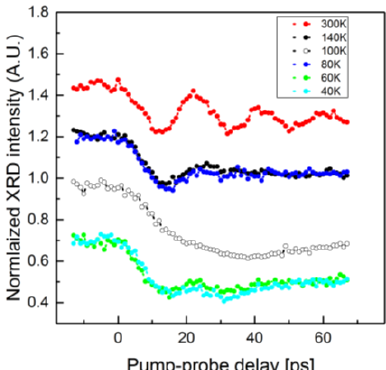
Fig. 1. The temperature dependence of the measured time dependent diffracted intensities probing the acoustic mode q=0.015π/a. The data for different temperatures have been shifted along the intensity axis for better visibility.